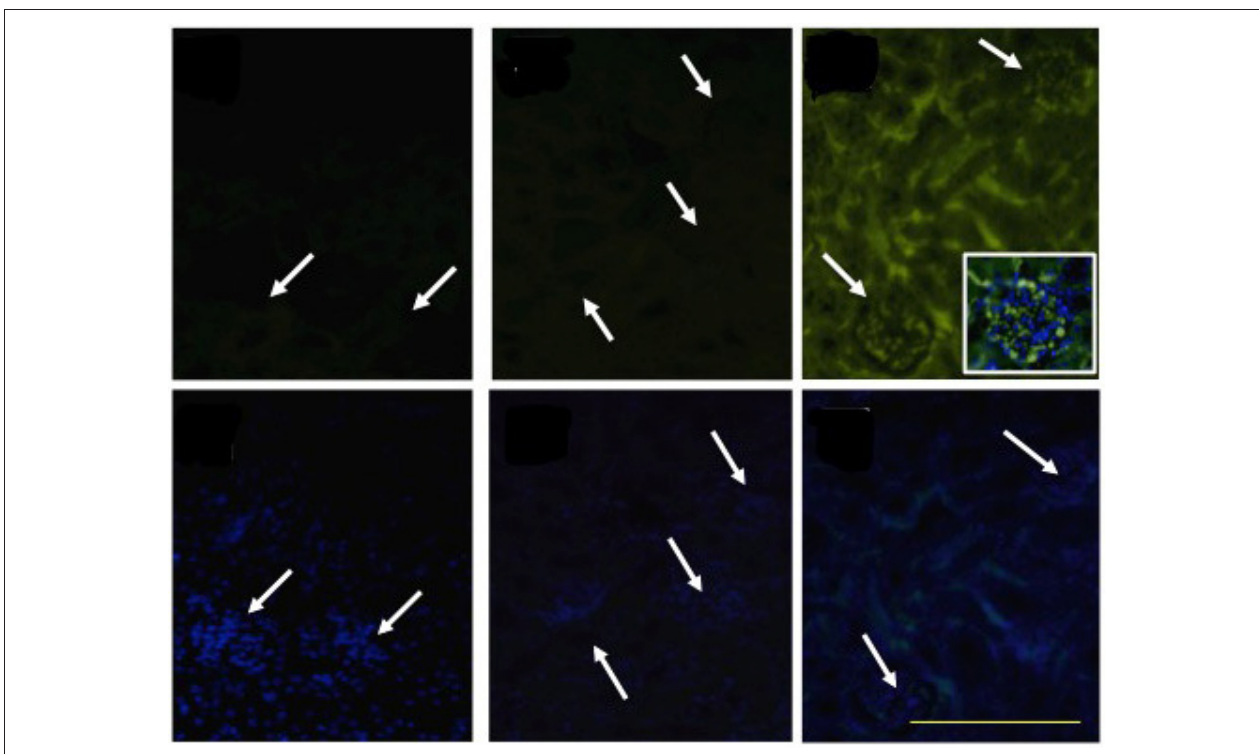
FIGURE 8 | SAA promotes TF accumulation in renal tissues. ApoE − / − mice were administered SAA, LPS or sterile PBS for 2 weeks (as described in Study 1). Tissue sections obtained from vehicle- (control), LPS- and SAA–treated mice were co-stained with an FITC-conjugated anti-TF antibody (Upper) or with DAPI alone (corresponding Lower) to highlight the nuclear envelope then imaged with an Olympus fluorescence microscope. No TF + immune-reactivity was detected in kidney tissue from control or LPS-treated mice. Arrows indicate clusters of DAPI-labeled nuclei localized to glomeruli that are detected in lower panels and reflected as a corresponding arrow in the corresponding panel above to indicate glomeruli in the same renal section. Data are representative of at least three different fields of view ( × 200 magnification) from each kidney section taken from n = 8 (control or LPS) or 10 (SAA) mice. Digital inset shows a representative overlay of DAPI and FITC fluorescence within a glomerulus (400 × magnification); scale bar, 200 µ